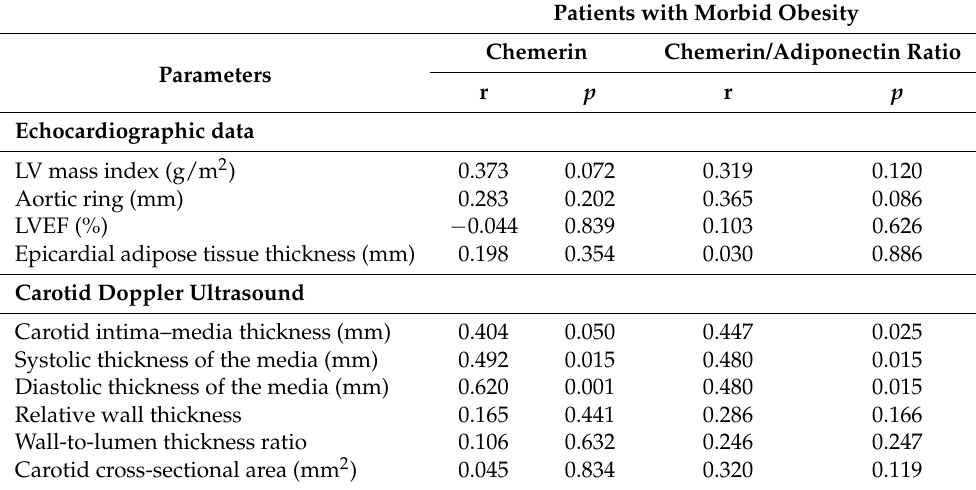
Table 2. Correlations between chemerin and chemerin/adiponectin ratio with imaging parameters.